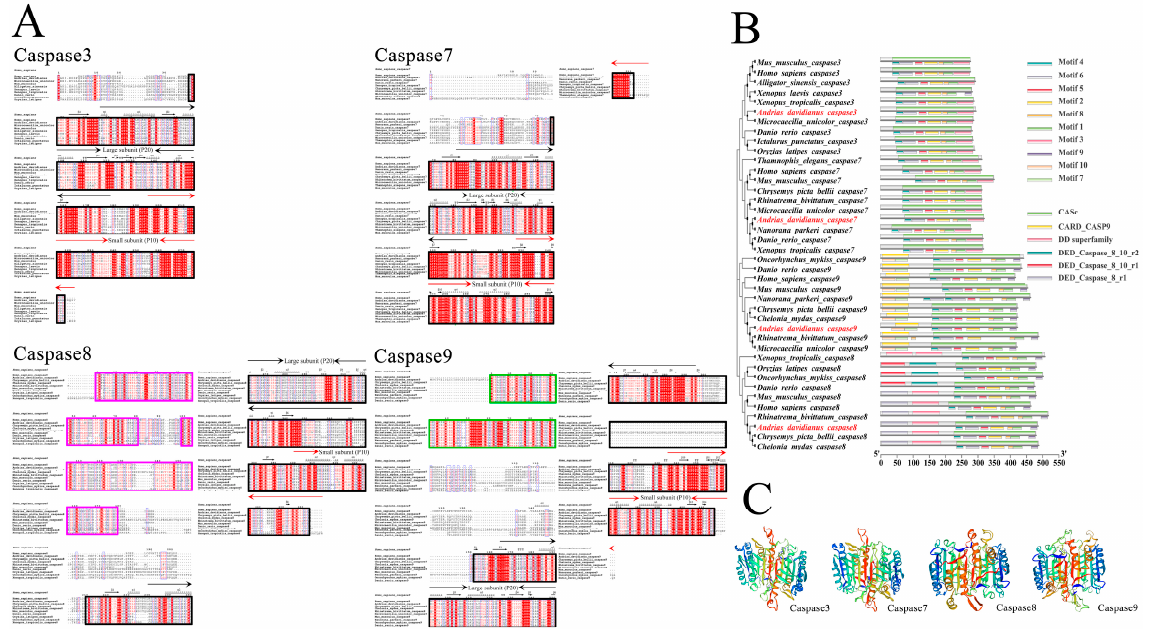
Figure 2. ( A ) Multiple sequence alignments of caspases 3/7/8/9 . A black box indicates a CASc domain; a purple box indicates a DED domain; a green box indicates a CARD domain; a black arrow indicates a P20 large subunit; a red arrow indicates a P10 small subunit. ( B ) Structural domain and motif prediction. ( C ) The tertiary structures of caspases 3/7/8/9 in the Chinese giant salamander.